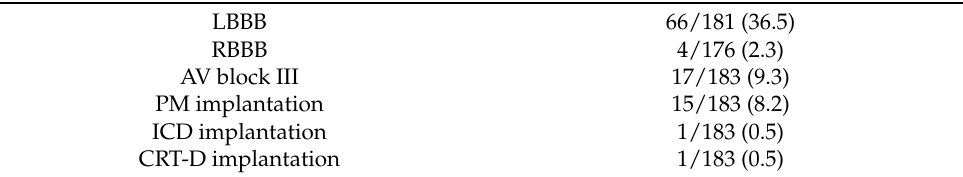
Table 1. Postoperative conduction disorders. LBBB 66/181 (36.5) RBBB 4/176 (2.3) AV block III 17/183 (9.3) PM implantation 15/183 (8.2) ICD implantation 1/183 (0.5) CRT-D implantation 1/183 (0.5) Values are given as absolute numbers with % in parentheses. AV block III, atrioventricular block III; CRT-D, cardiac resynchronization therapy–defibrillator; ICD, implantable cardioverter defibrillator; LBBB, left bundle branch block; RBBB, right bundle branch